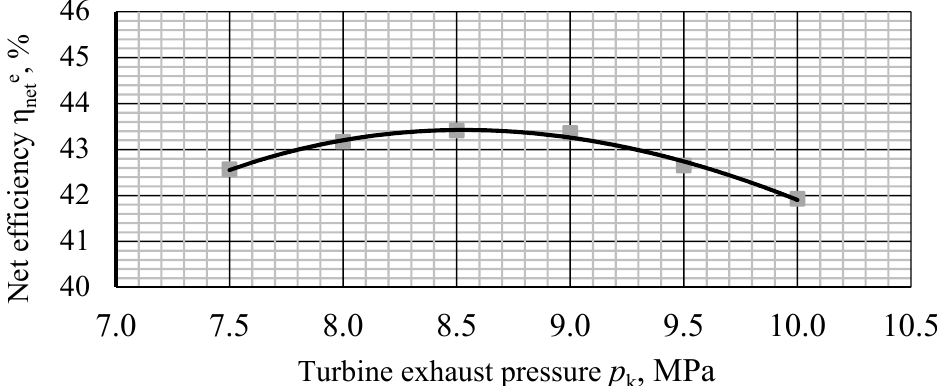
Figure 4. Dependence of the cycle net efficiency on carbon dioxide turbine exhaust pressure.